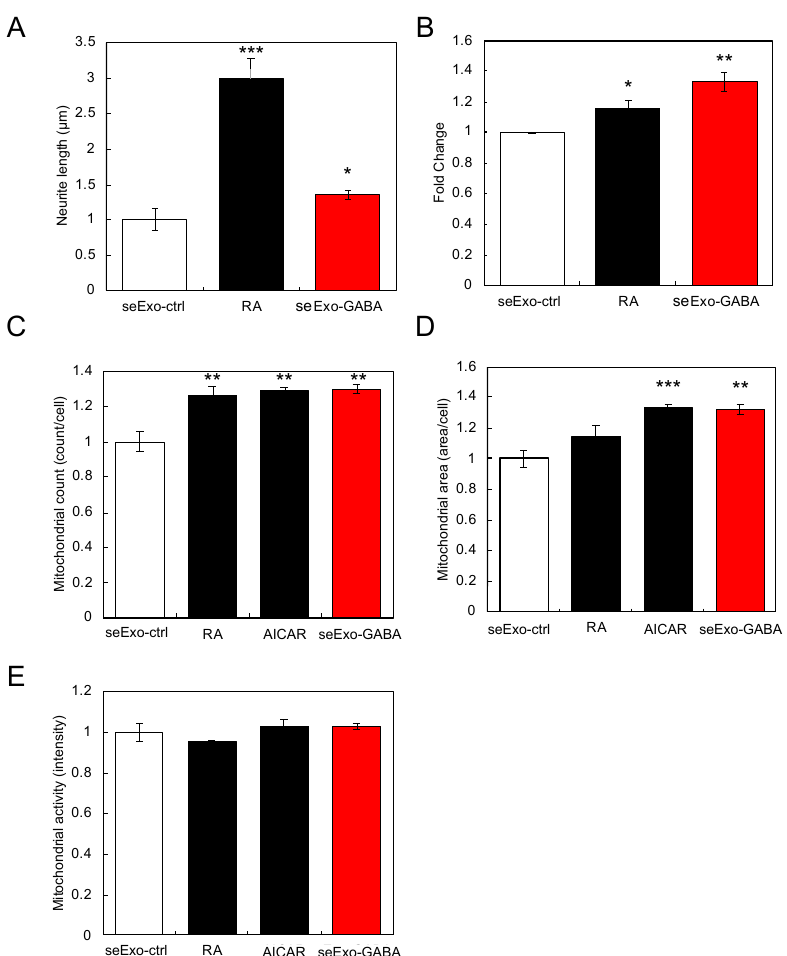
Figure 4. Effects of exosomes derived from serum of GABA-treated mice (seExo-GABA) on SH- 255 SY5Y cells. Exosomes derived from serum of non-treated mice (seExo-ctrl) was used as control. 256